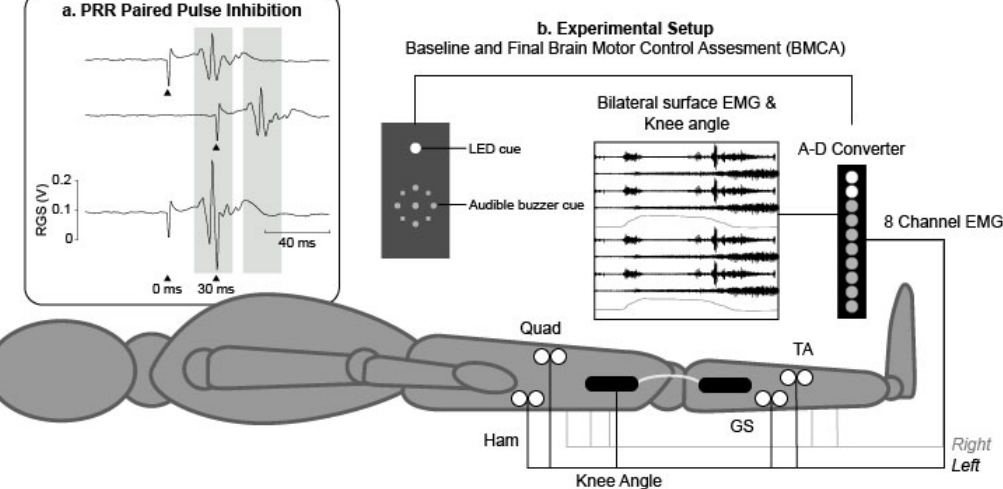
Figure 2. ( a ) Example traces during posterior root reflex (PRR) testing; single pulses were delivered at 0 and 30 ms (upper traces) and as a pair with an interstimulus interval (ISI) of 30 ms (lower trace) to demonstrate paired pulse inhibition (arrows denote the time at which the stimulus was applied). ( b ) Experimental setup for baseline and final Brain Motor Control Assessments. Participants were placed in a supine position with bilateral electromyography (EMG) electrodes placed over the Quadriceps (Quad), Hamstring (Ham), Tibialis Anterior (TA) and Gastrocnemius (GS) muscles to record EMG and electro-goniometers were placed laterally across the knee joints to synchronously record knee joint range of motion.